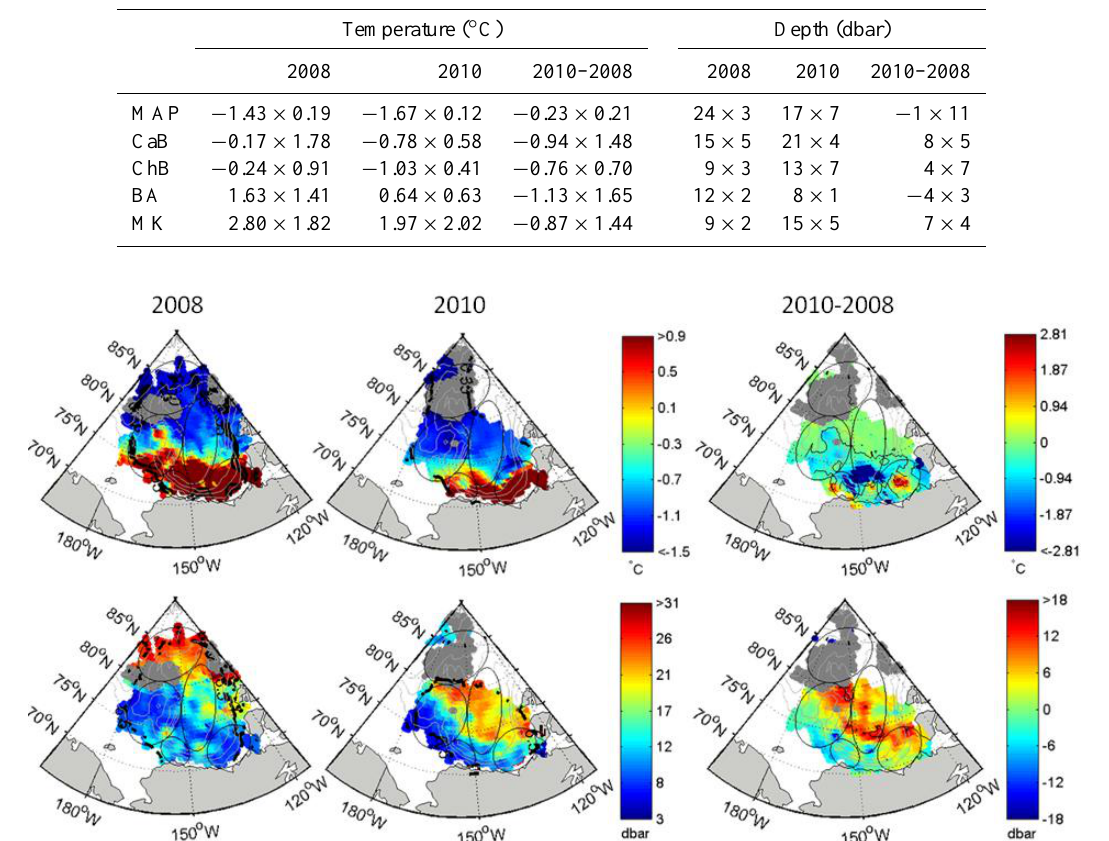
Fig. 7. Kriging interpolation of the near-surface temperature maximum (NSTM, top) and its depth level ( Z NSTM , bottom), for years 2008 (left panel) and 2010 (middle panel), and the evolution between the two years (right panel). Grey areas correspond to the absence of the NSTM. In the left and middle panels, thick black dashed isolines correspond to estimation error ( σ ) due to Kriging interpolation process. The isolines represented are σ = 0.35 ◦ C and σ = 7 ◦ C for NSTM, and σ = 6.5dbar and σ = 7dbar for Z NSTM . In the right panel, thin black isolines correspond to 95% significance.